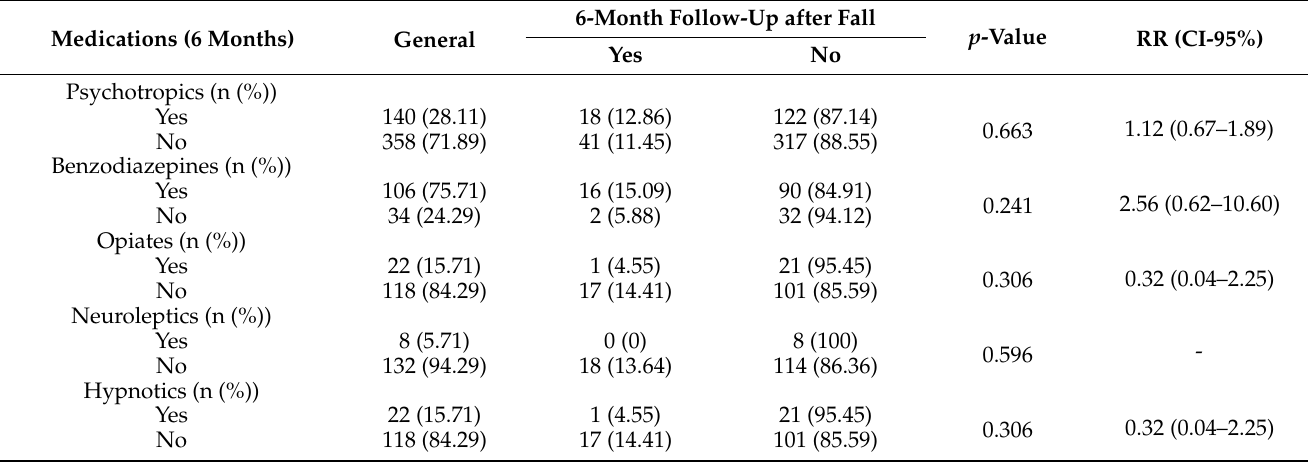
Table 3. Relationship between falls in the six-month follow-up and